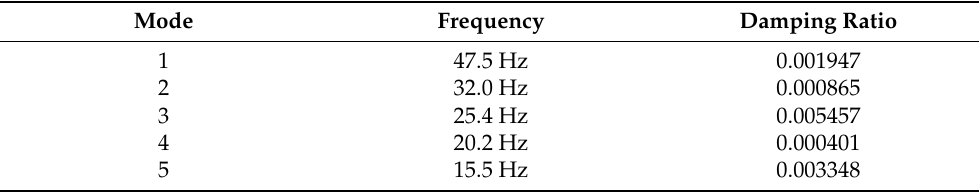
Table 2. Torsional modes of the steam turbine generator unit.